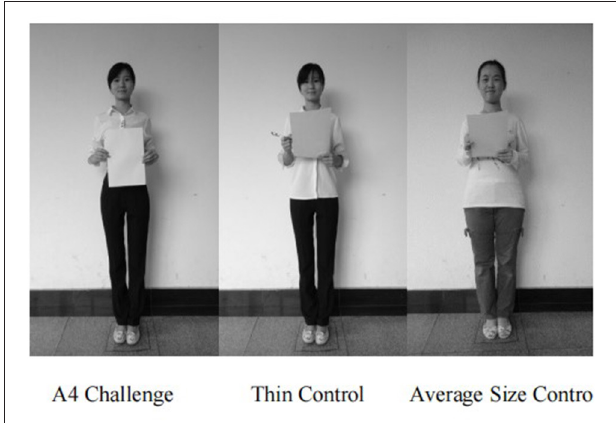
FIGURE 2 | Sample images for each condition of thin ideal exposure experiment.